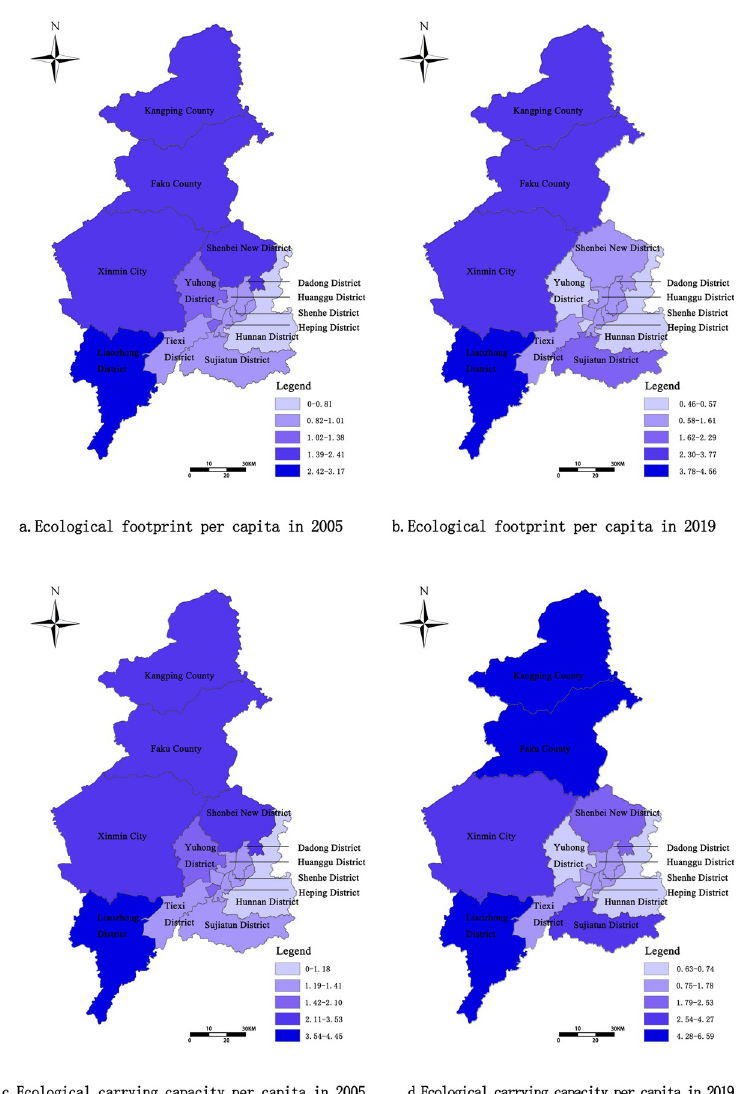
Fig 3. Spatial evolution pattern of ecological footprint and ecological carrying capacity of Shenyang in 2005 and 2019 (Image source: https://www.naturalearthdata.com/downloads/10m-cultural-vectors/). a. Ecological footprint per capita in 2005. b. Ecological footprint per capita in 2019. c. Ecological carrying capacity per capita in 2005. d. Ecological carrying capacity per capita in 2019.